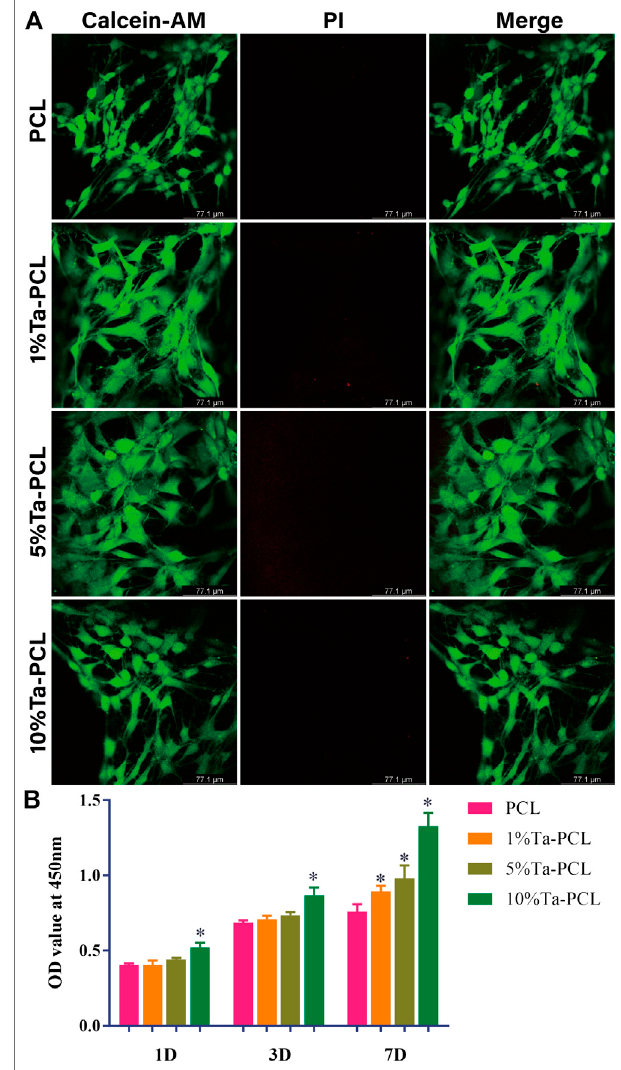
FIGURE 3 | Cell viability of Ta/PCL scaffold. (A) Live/Dead assay of MSCs cultured in the scaffold after 3 days. (B) The CCK8 assay of MSCs when cultured with Ta/PCL after 1 day, 3 days and 7 days * p < 0.05 vs